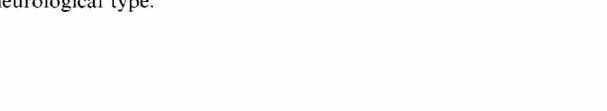
Figure 1. Enzyme-Linked lmmunosorbent Assay (ELISA) for quantitation of the folate binding protein in human cerebro spinal fluid. Typical dose-response curves obtained after serial (two-fold) dilution of the samples. The folate binding protein concentration of the undiluted calibrator (e) was 0.45 nmol!l as determined by radioligand binding (reference method). Other symbols denote patients with no complaints or diseases of neurological type.